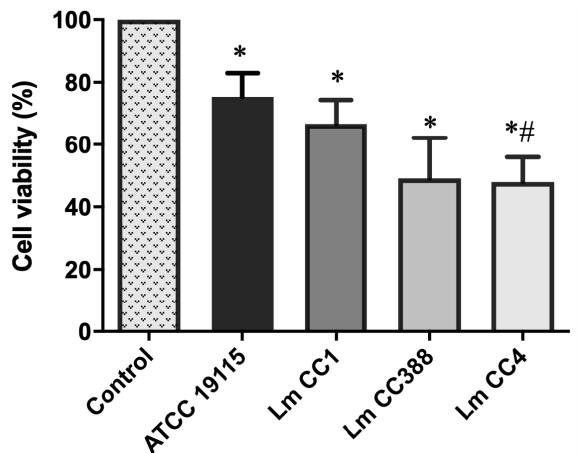
Figure 2. Cytotoxic activity of L. monocytogenes . Cell viability of A549 cells with L. monocytogenes Lm CC388, Lm CC1, Lm CC4 and ATCC 19115 strains for 24 h. Data are the means of 3 repetitive assays. *: p < 0.05 versus control, #: p < 0.05 versus ATCC 19115.